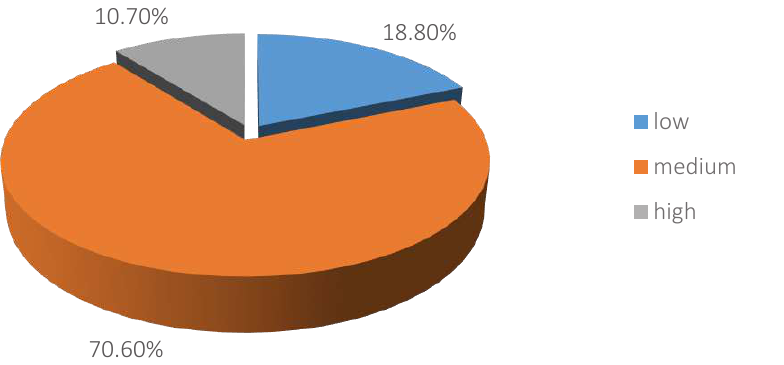
Figure 3. Responses to the question: How would you assess the competitiveness of Georgian agri-food products in the local Table 1. Results of the factor assessment by consumers